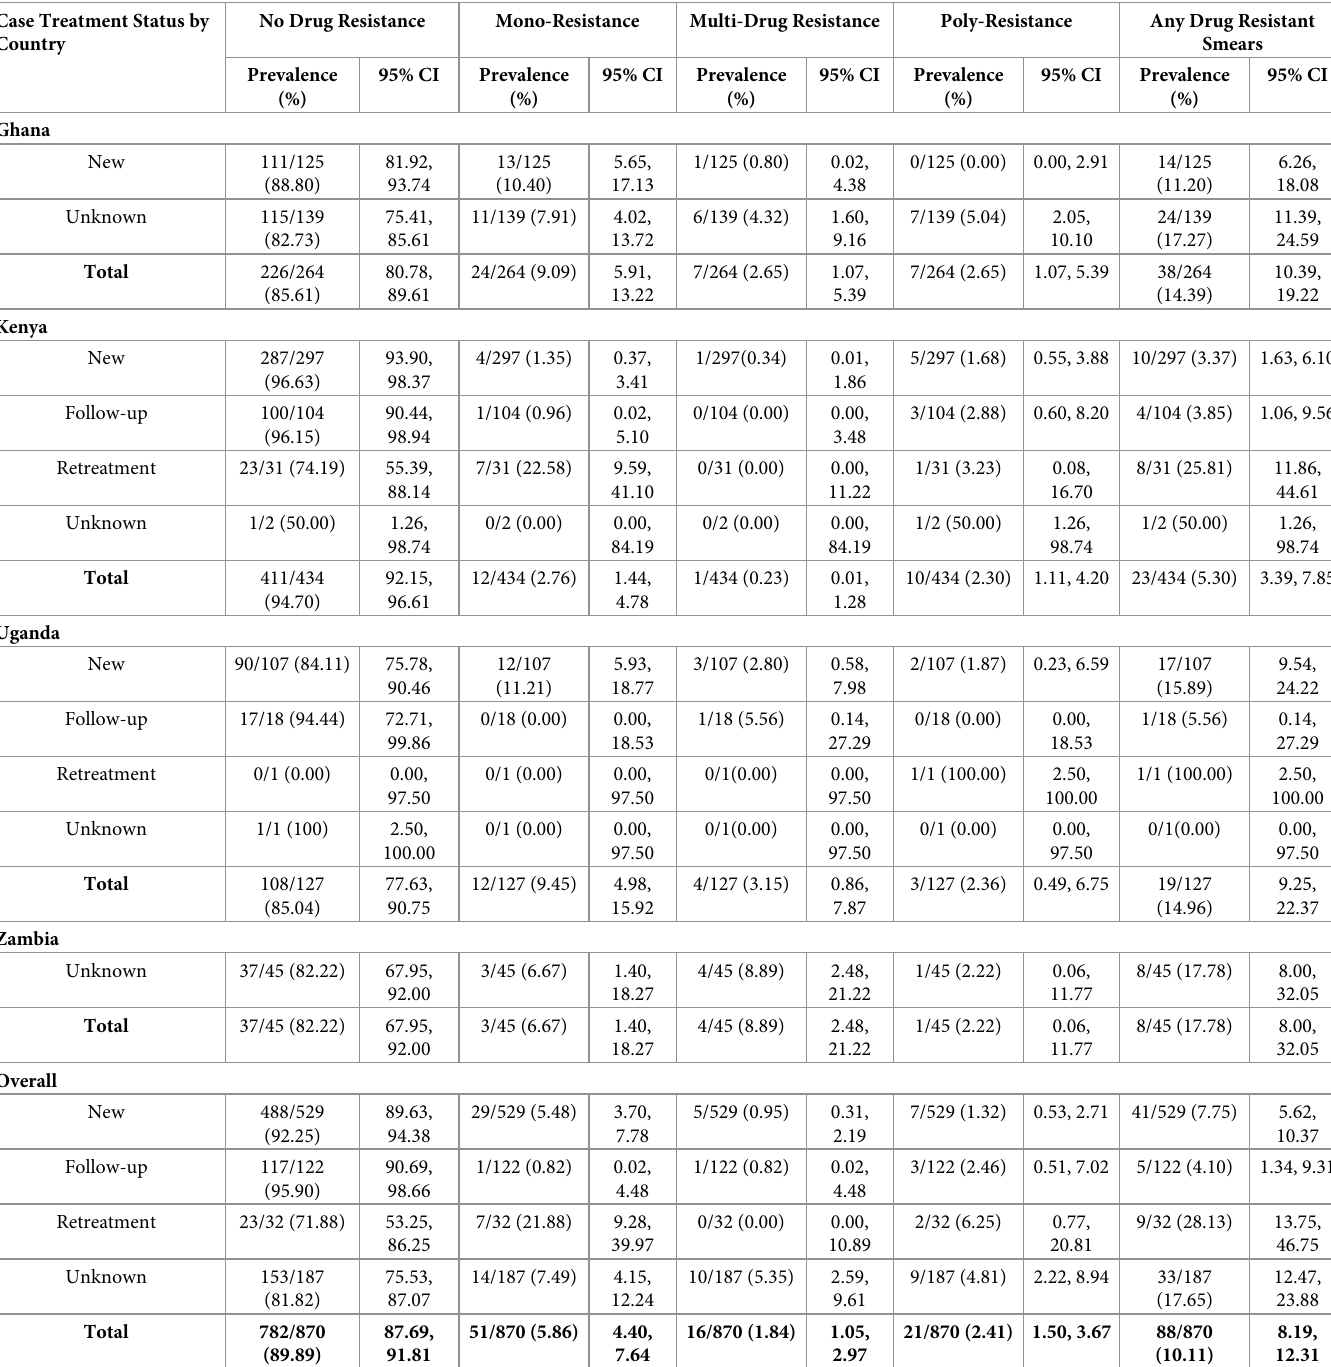
Table 5. Overall and country specific prevalence and 95% confidence intervals for phenotypic interpretation of observed mutations in smears with interpretable results for all gene targets, by case treatment status. Case Treatment Status by